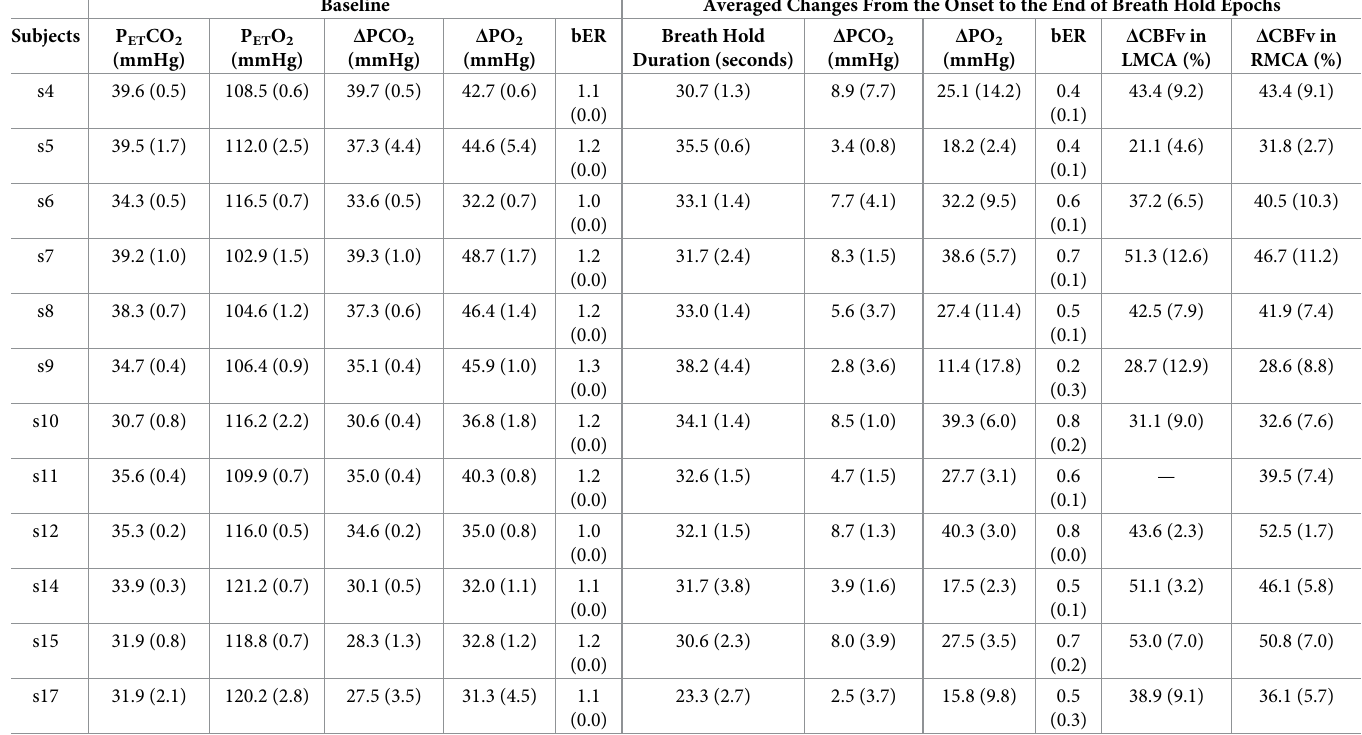
Table 2. RGE metrics and Δ CBFv in TCD sessions. Baseline Averaged Changes From the Onset to the End of Breath Hold